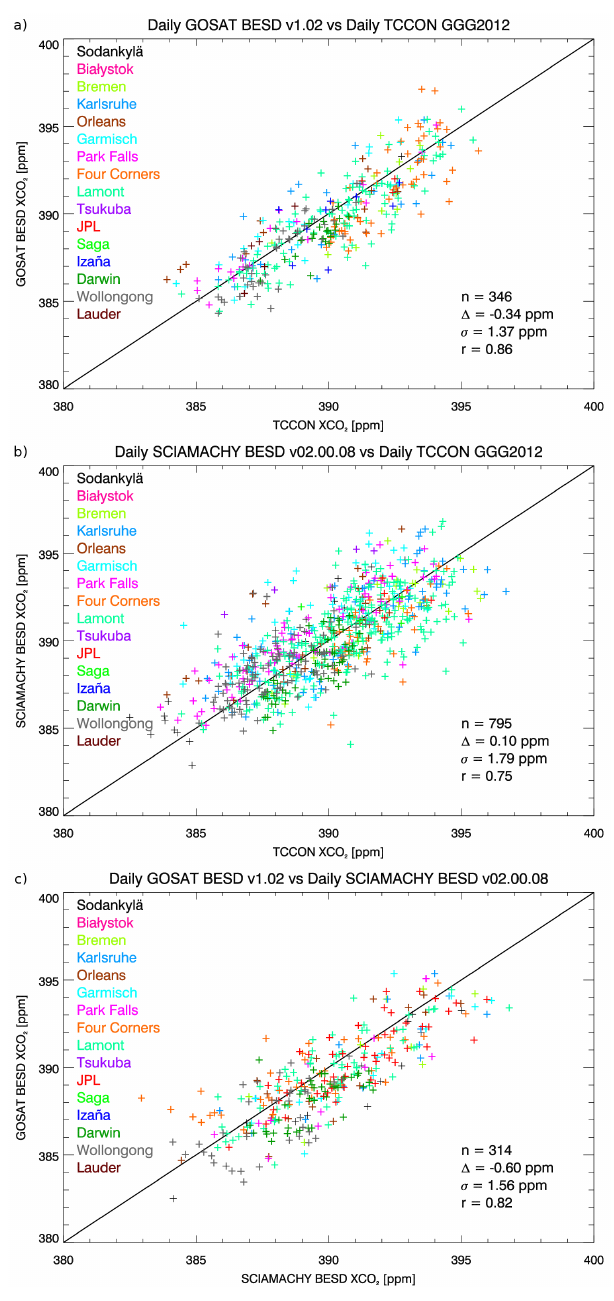
Figure 6. As Fig. 5 but for daily averages of GOSAT, SCIA- MACHY and TCCON XCO 2 (2010–2011). (a) GOSAT BESD XCO 2 vs. TCCON XCO 2 . (b) SCIAMACHY BESD XCO 2 vs. TC- CON XCO 2 . (c) GOSAT BESD XCO 2 vs. SCIAMACHY BESD XCO 2